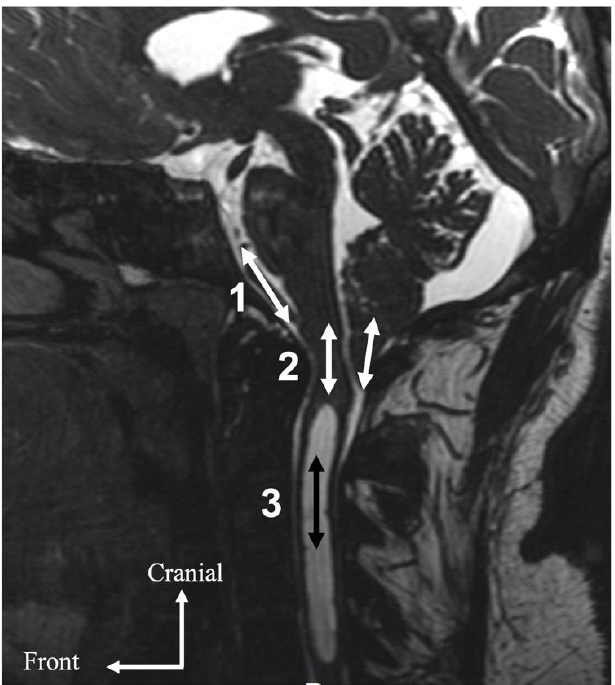
Figure 2. Local hydrodynamic localization of a Chiari malformation. The complete or partial alteration of CSF flow via the foramen magnum results in the transmission of CSF pulsatility from the intracranial subarachnoid spaces (1) to elongated marrow and cerebellar tonsils (2). This pulsatility is subsequently transmitted to the subarachnoid CSF or the syringomyelic cavity (3).